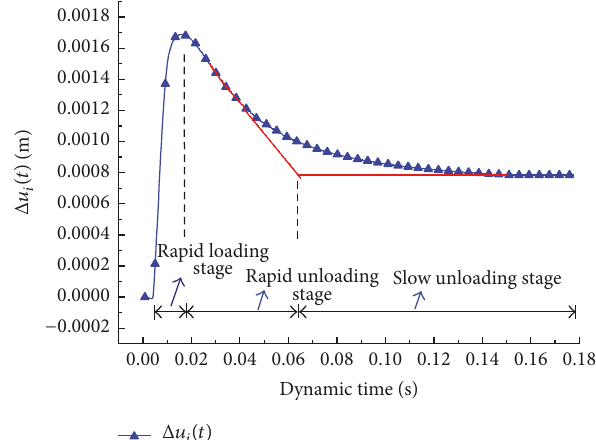
Figure 3: Typical curve of Δ𝑢 𝑖 (𝑡) with time for the wave converter.